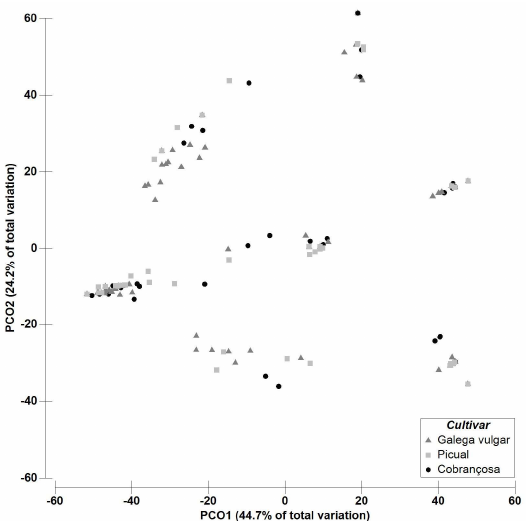
Figure 3. Principal coordinates analysis PCO based on the fungal richness dataset for the factor Figure3. “Cultivar” ‘Galega vulgar’, ‘Cobrançosa’ and ‘Picual’ (3 levels, random). PCO1 = 24.2% and PCO2 = 44.7%.